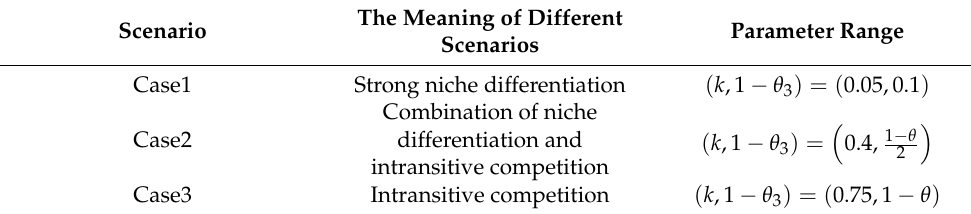
Table 1. Three coexistence